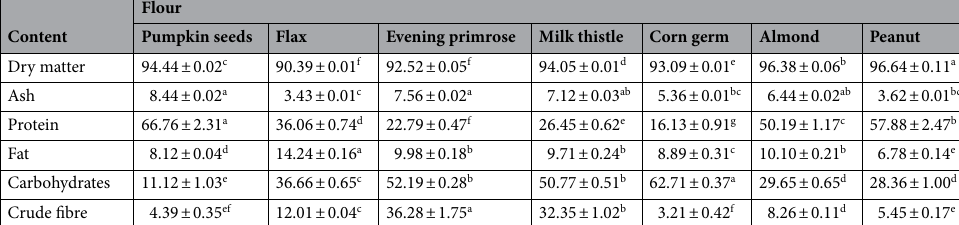
Table 2. Chemical composition (g/100 g) of selected cold-pressed seed flours. Values are means ± SD of two determinations. a,b,c,d,e,f The same letter in verse mean homogenous